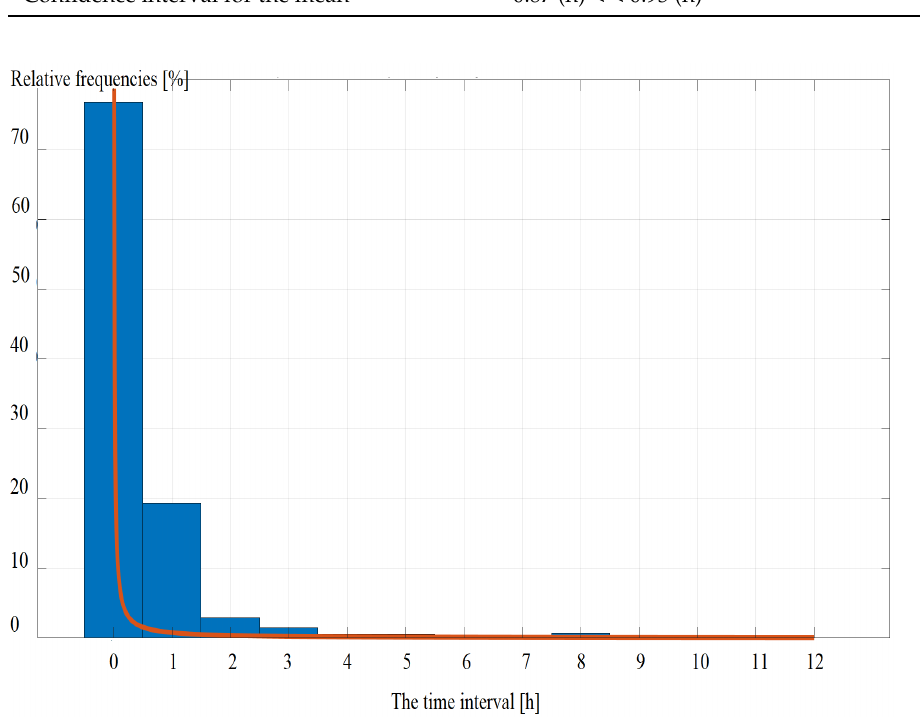
Figure 6. Empirical and theoretical probability density function of MV line renewal duration (num- bers 0–12 define the failure interval in an increasing way: 0: 0–1 (h), 1: 1–2 (h), 2: 2–3 (h) . .